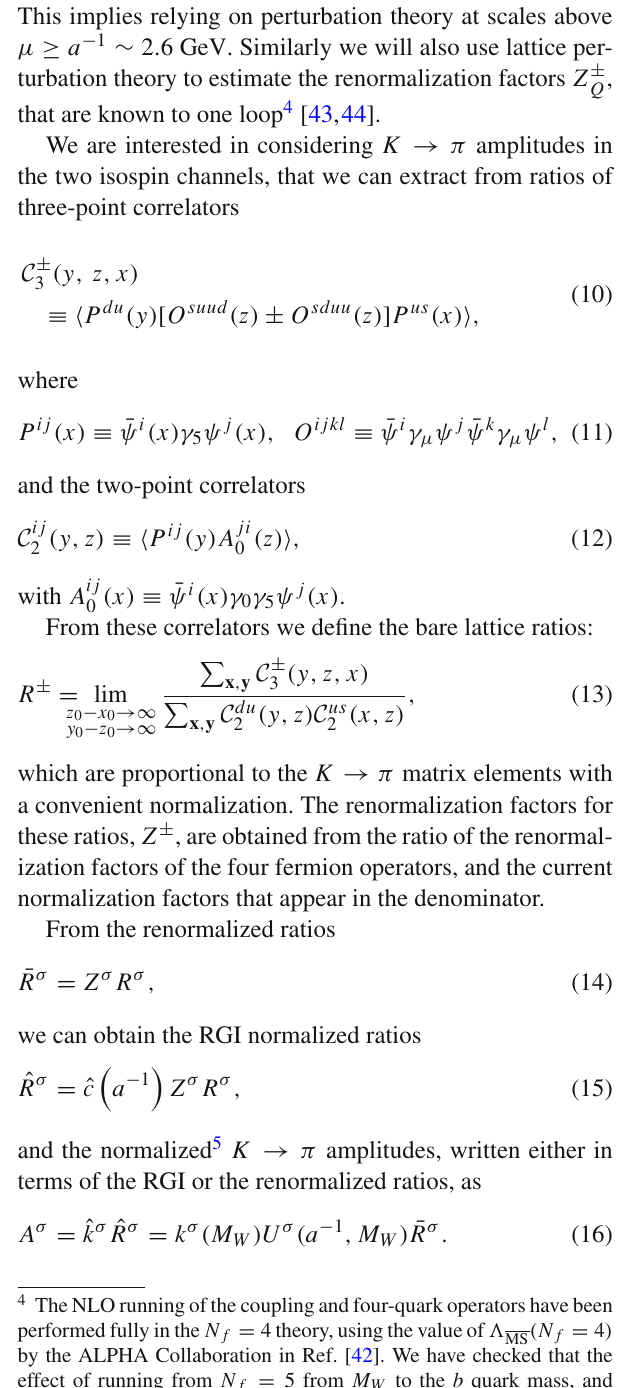
(cid:4) (cid:5) a − 1 have been computed at (cid:4) (cid:5) ( N = a − 1 we have used (cid:10) f MS